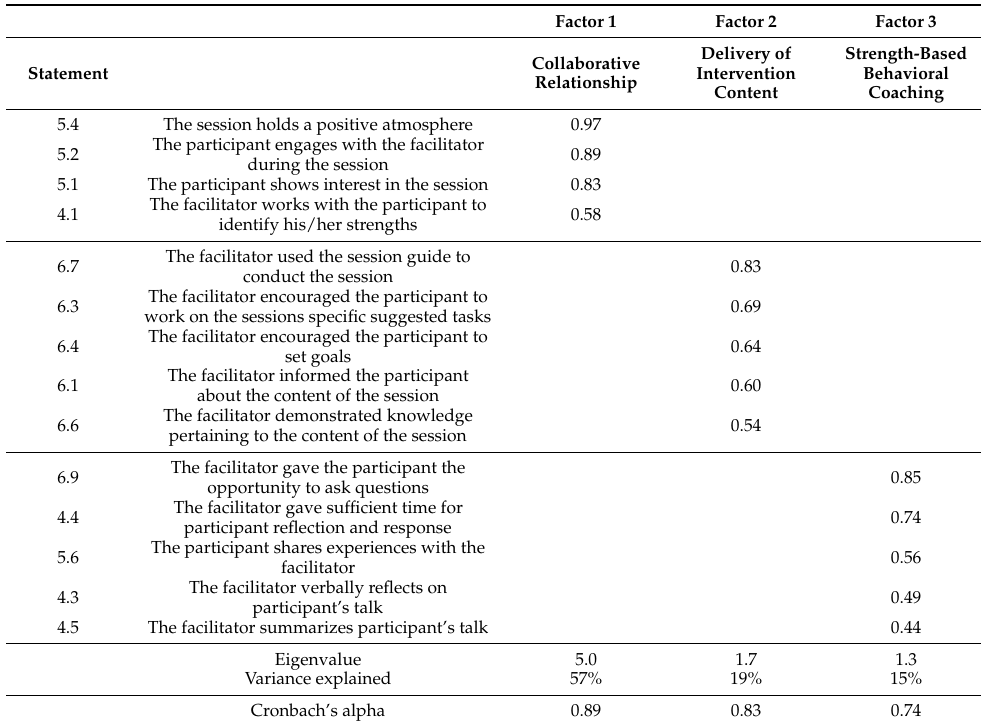
Table 2. Factor score distribution for the final domains (Likert summated